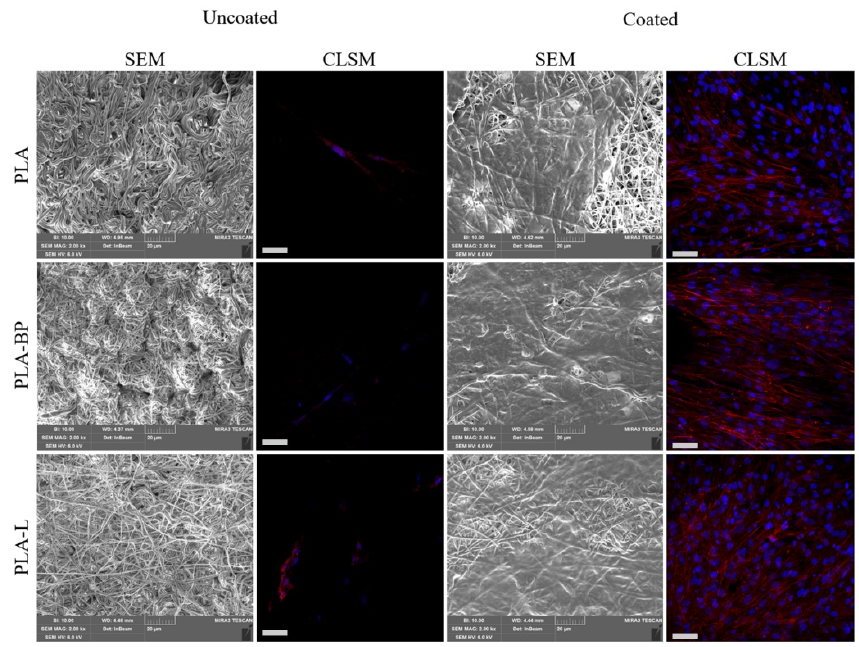
Figure 9. Microphotographs of fibroblasts grown on PLA, PLA-BP, PLA-L fibres, uncoated and coated, for 7 days: SEM images and confocal-laser scanning microscopy (CLSM) (nuclei in blue, Hoechst 33258; cytoskeleton in red, TRICT-phalloidin). Scale bars: 20 μ m for SEM images, 50 μ m for CLSM images.